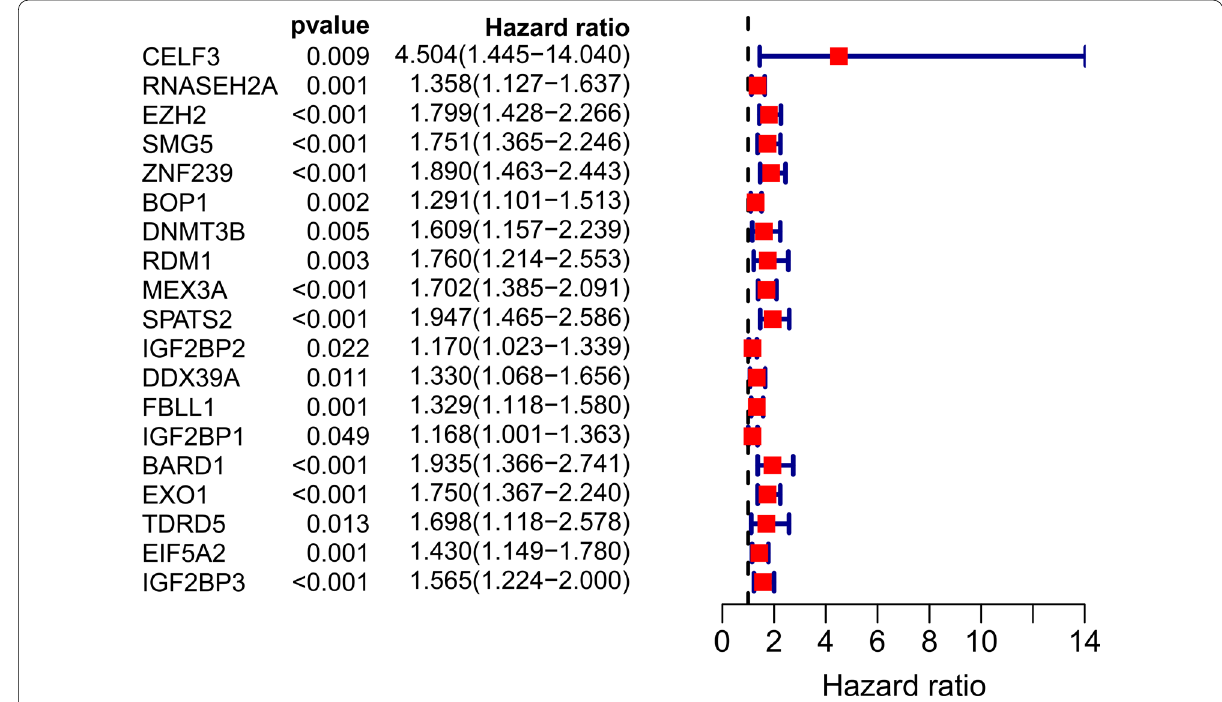
Fig. 3 Univariate Cox regression analysis of differentially expressed RBPs